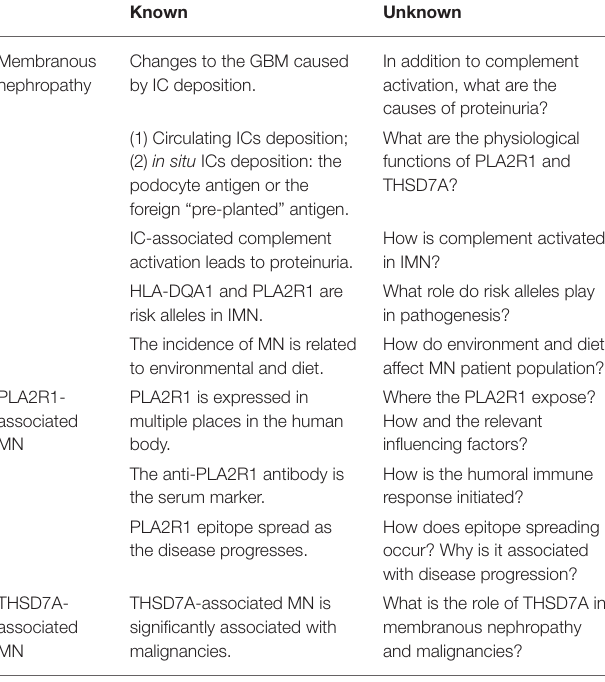
TABLE 3 | Known and unknown about the pathogenesis of membranous